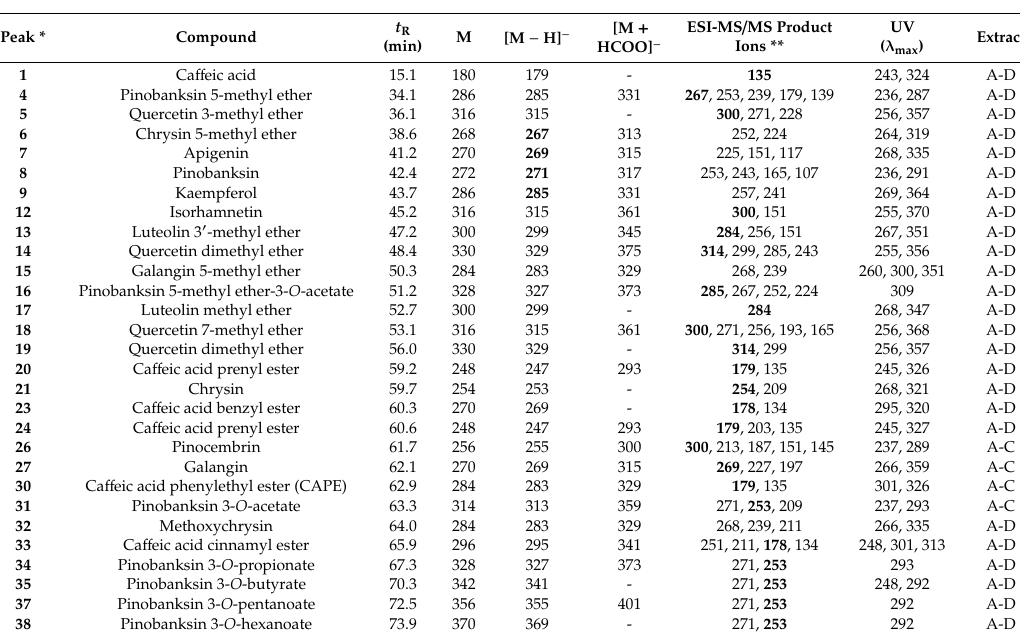
Figure 1. LC-ESI-MS / MS chromatograms, registered in negative ion mode, of four extracts of Italian Figure 1. LC-ESI-MS/MS chromatograms, registered in negative ion mode, of four extracts of Italian propolis collected in the Campania region. Peak data are shown in Table 1. propolis collected in the Campania region. Peak data are shown in Table 1. Chromatographic ( t R = retention time), UV, and negative ion mode electrospray ionization—tandem mass spectrometry (ESI-MS / MS) data of the constituents identified in Italian propolis extracts: A, Pietradefusi; B, Melito Irpino; C, Melizzano; D,